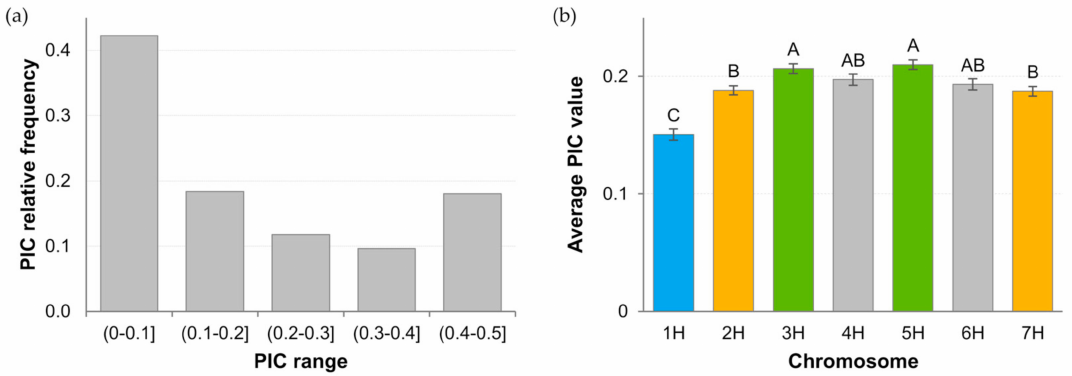
Figure 2. Summary of polymorphism information content (PIC) values. ( a ) Range of relative fre- quencies for all analyzed DArTseq loci in 83 spring barley cultivars; ( b ) Mean PIC value including chromosomal location of studied DArTseq loci. Letters above the bars in the graph indicate homoge- neous groups determined by Tukey’s post hoc test.